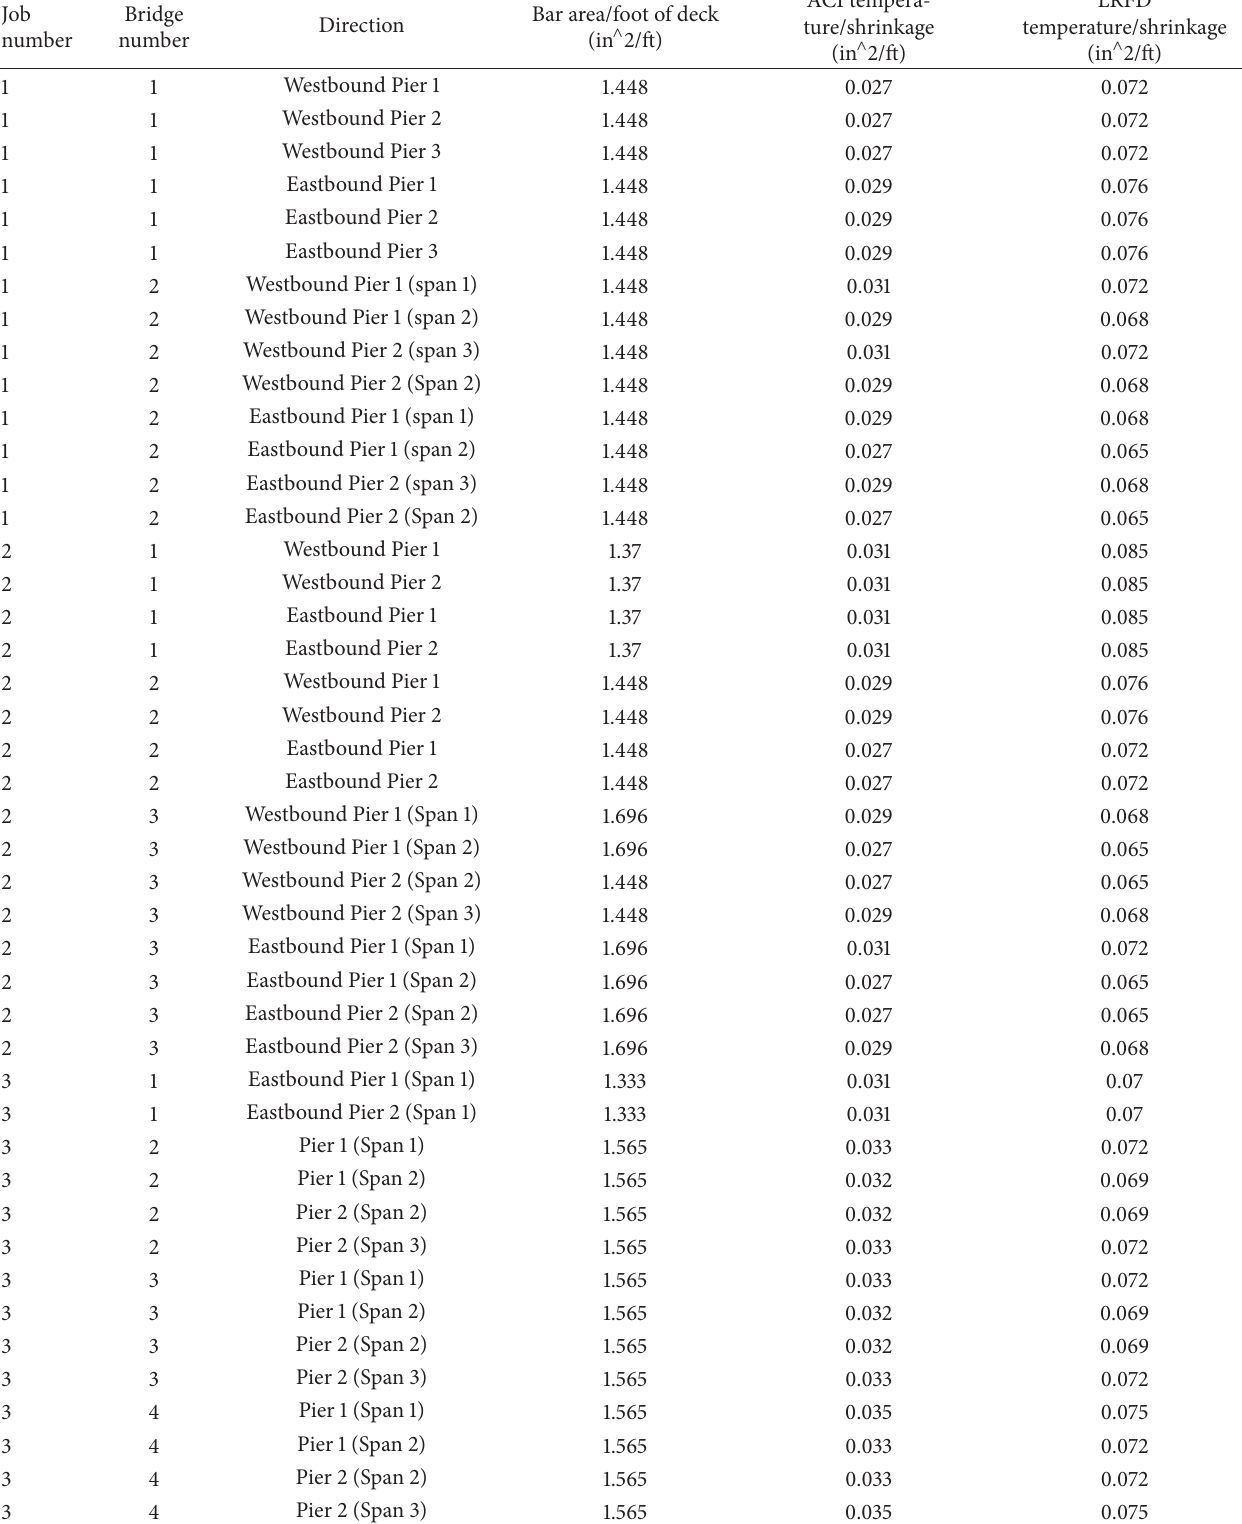
Table 1: Temperature and shrinkage steel calculations for bridge